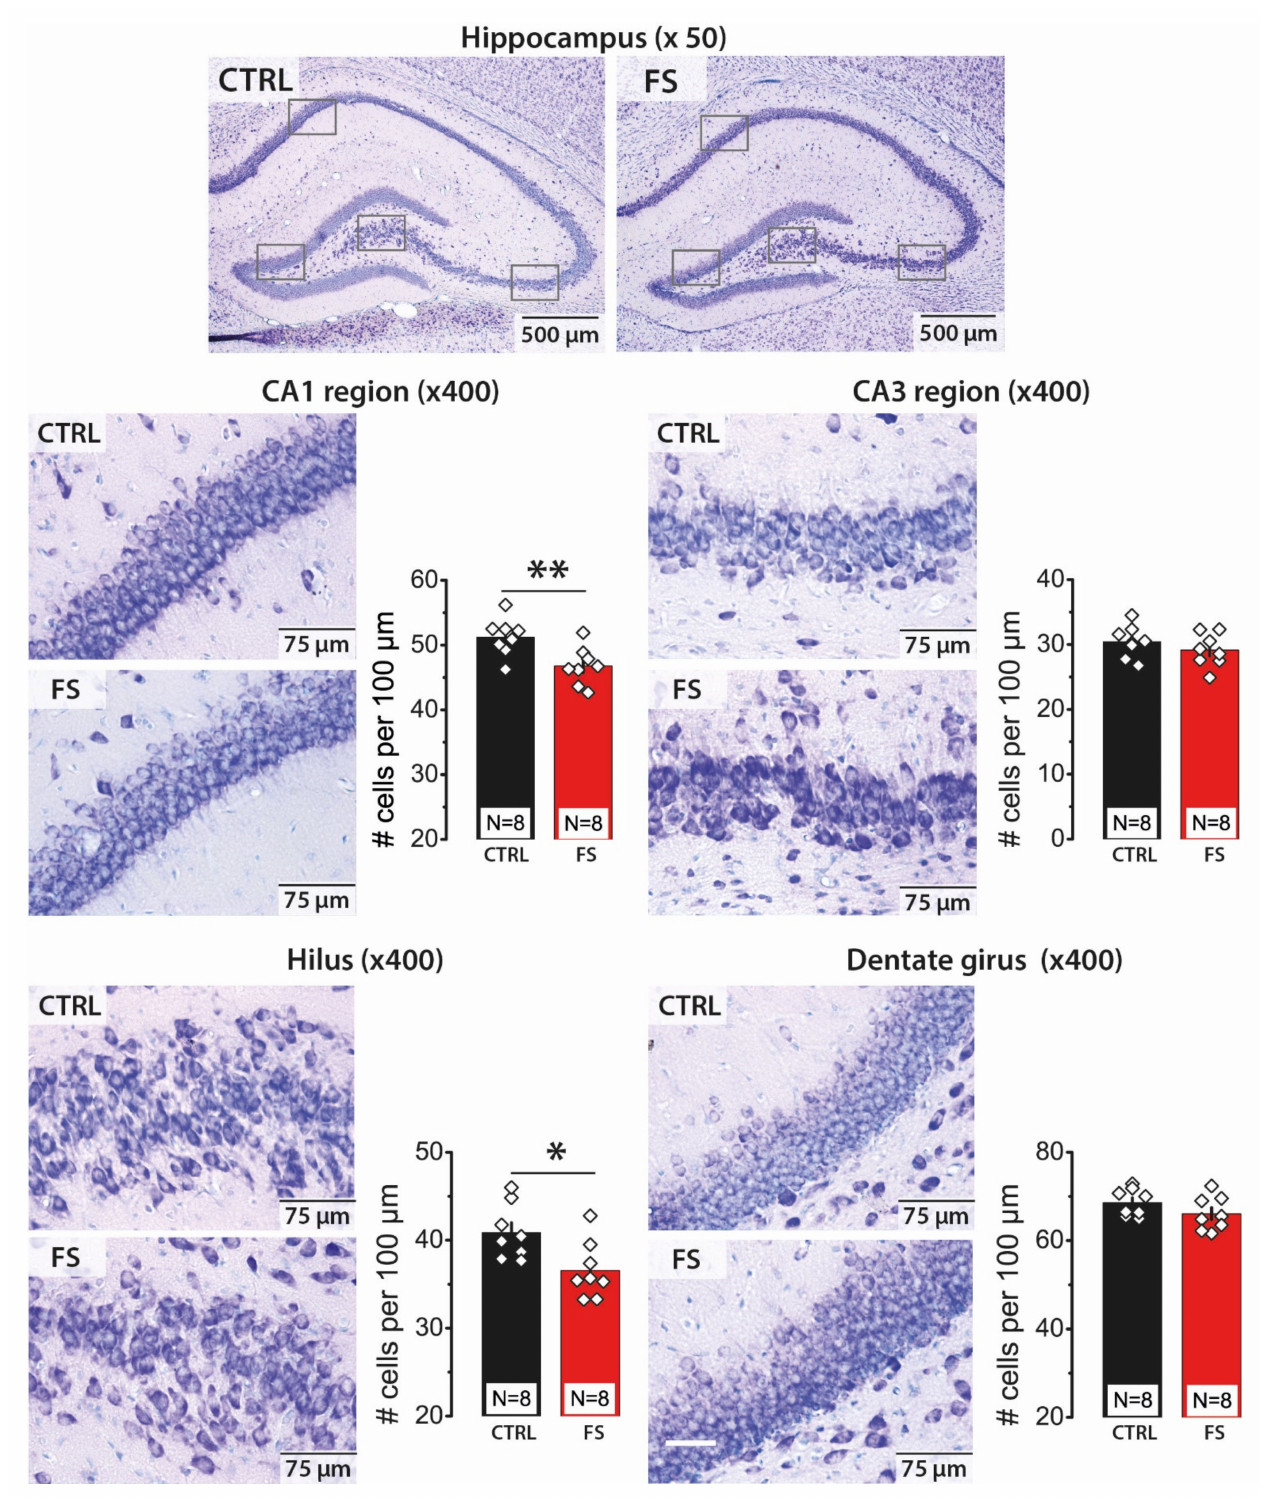
Figure 1. Nissl staining of the neurons in control (CTRL) and FS rats (FS) in the hippocampal areas CA1, CA3, hilus and dentate gyrus (DG). Group data of the counted Nissl stained neurons per 100 µ m of the cellular layer. The rhombuses show individual values per brain. The bars indicate average values, and error bars show standard errors of the means. * p < 0.05, ** p < 0.01, t